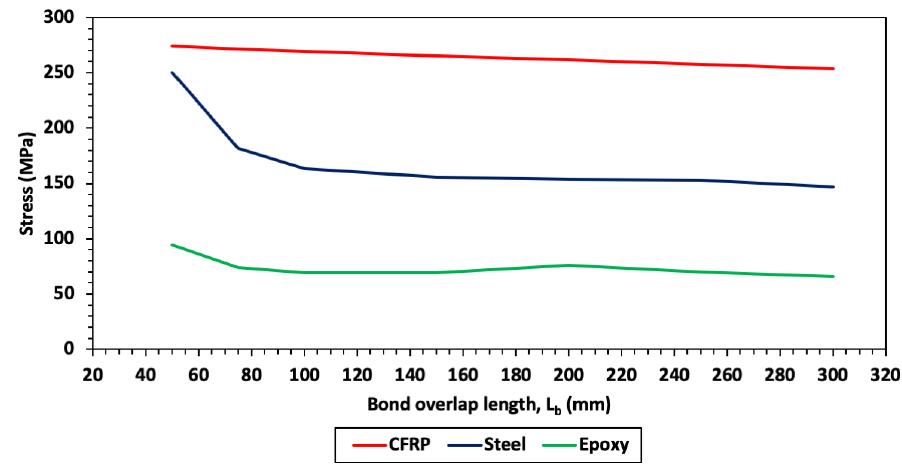
Figure 8. Maximum stress in each component of the hybrid metallic-composite railway axle assembly over a range of bond overlap lengths.